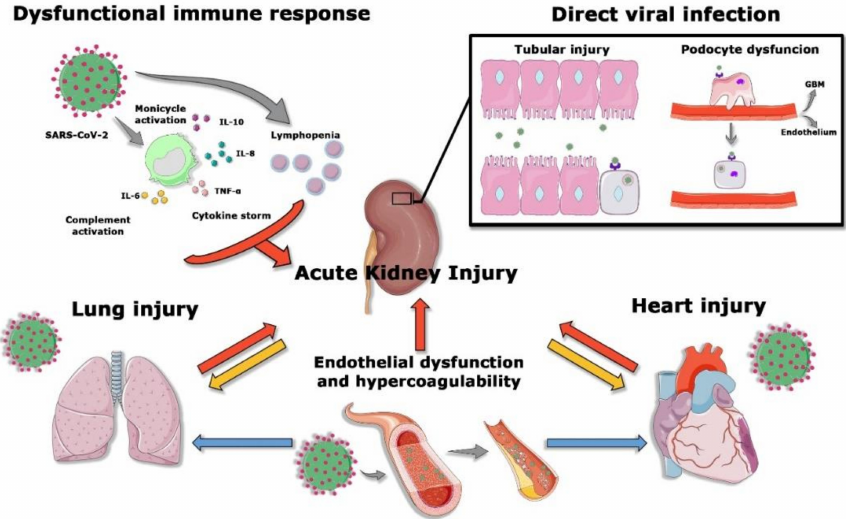
Figure 2. Etiology of AKI in SARS-CoV-2 infection. Several mechanisms contribute to AKI development in COVID-19 patients. The dysfunctional immune response characterized by the production of various proinflammatory cytokines, the complement system activation, and the T cell impairment lead to renal injury. On the other hand, SARS-CoV-2 penetrates tubular cells and podocytes, leading to acute tubular necrosis and podocyte dysfunction. The endothelial damage and the activation of the coagulation system participate in the development of AKI. Moreover, both lung and heart injury a ff ect renal function. In the same way, the kidney hampers lung and heart